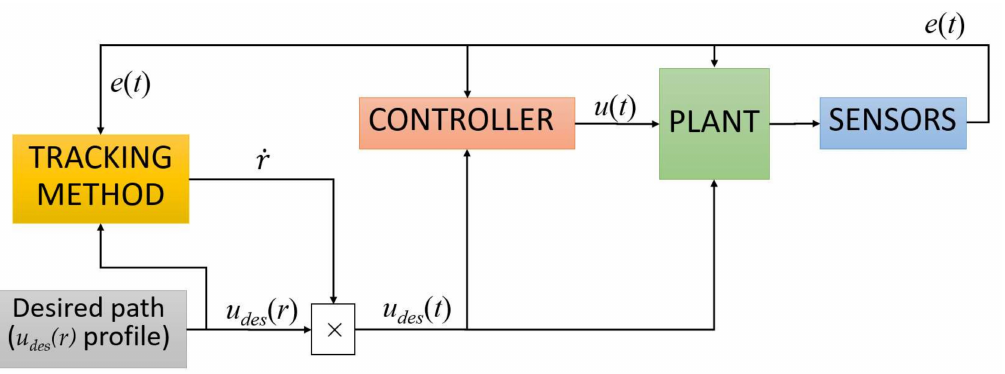
Figure 2. Diagram block of the control of a plant that considers the descriptor parameter